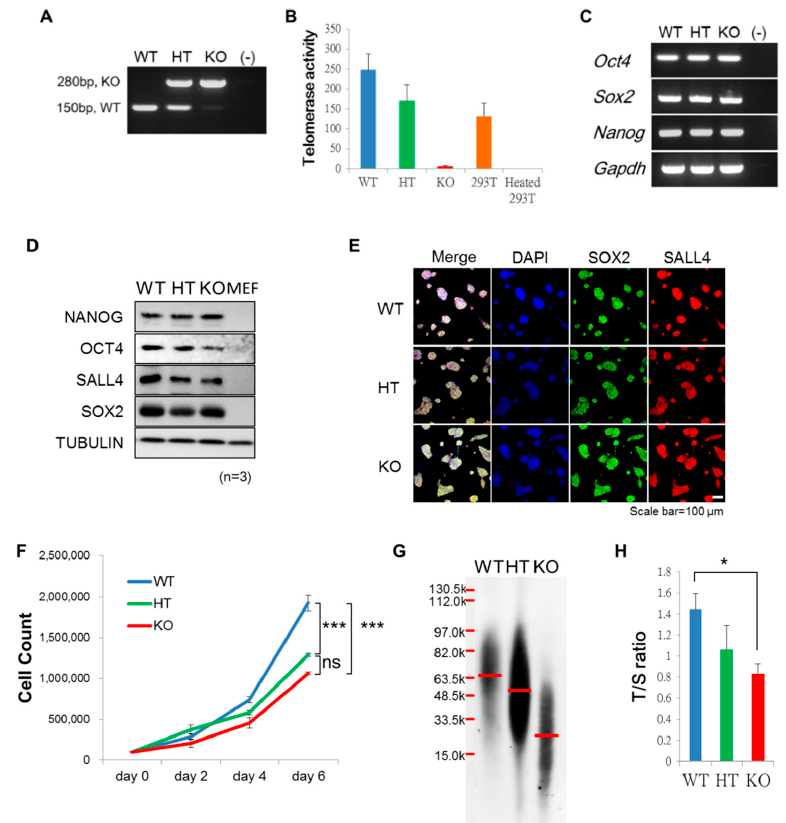
Figure 1. Characterizations of nuclear transfer embryonic stem cells (ntESCs) with different Terc genotypes. ( A ) Genotyping of Terc +/+ (WT), Terc +/ − (HT) and Terc − / − (KO) ntESCs. (–): negative control without template DNA. The 280 bp band indicates the KO allele and the 150 bp band indicates the wild-type allele. ( B ) Telomerase activity is assayed by Telomerase Repeated Amplification Protocol (TRAP) assay for each Terc genotype. Positive control is human 293T cells (293T), and the heat-inactivated 293T cells (Heated 293T) is used as negative control. Error bar indicates the standard deviation (SD). ( C ) Detection of pluripotent markers by semi-quantitative reverse transcription-polymerase chain reaction (RT-PCR). (–): negative control without template cDNA. ( D ) Western blot analysis of pluripotency by detecting NANOG, octamer-binding transcription factor 4 (OCT4), Sal-like protein 4 (SALL4), and SRY (sex determining region Y)-box 2 (SOX2) in ntESC lines. TUBULIN is used as the internal control. Mouse embryonic fibroblast (MEF) is used as the negative control for pluripotent markers. ( E ) Immunofluorescent staining shows the positive signal of SOX2 and SALL4 in ntESC lines. 4 (cid:48) ,6-diamidino-2-phenylindole (DAPI) is used for nuclei stain. ( F ) Growth curve of ntESCs in six-days of culture in embryonic stem cell (ESC) medium ( n = 3). *** indicates significant difference between groups ( p < 0.001). ns: no significant differences. ( G ) Telomere length analysis by telomere restriction fragment (TRF) in three genotypes of ntESCs. Red line indicates the medium length of genomic DNA. ( H ) Comparison of telomere length by telomere to single-copy gene ratio (T/S ratio). * indicates significant difference between groups ( p < 0.05) analyzed by unpaired student t